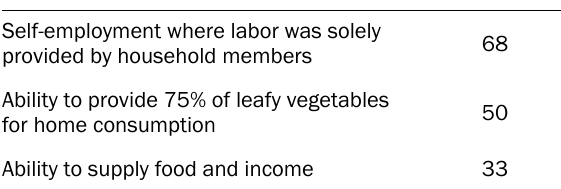
Table 2. Benefits Derived From Wastewater Farming According to Interviewed